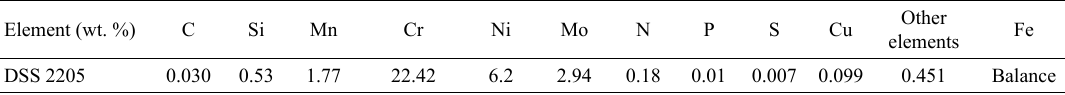
Table 1. Chemical composition of the DSS SAF 2205 (UNS S32205/S3180). Element (wt.